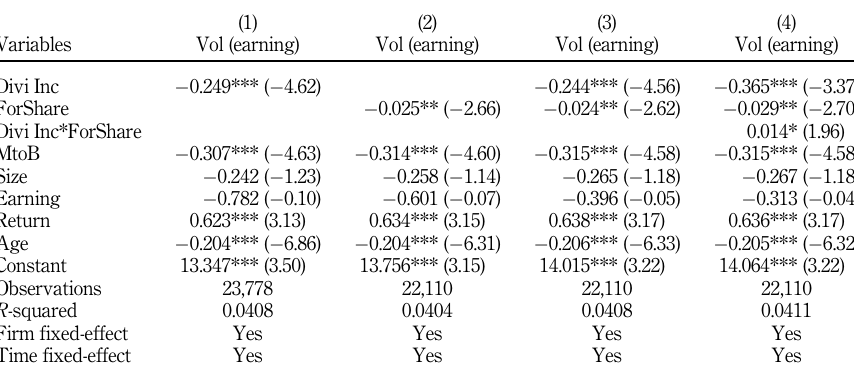
Table 8. Alternative measure